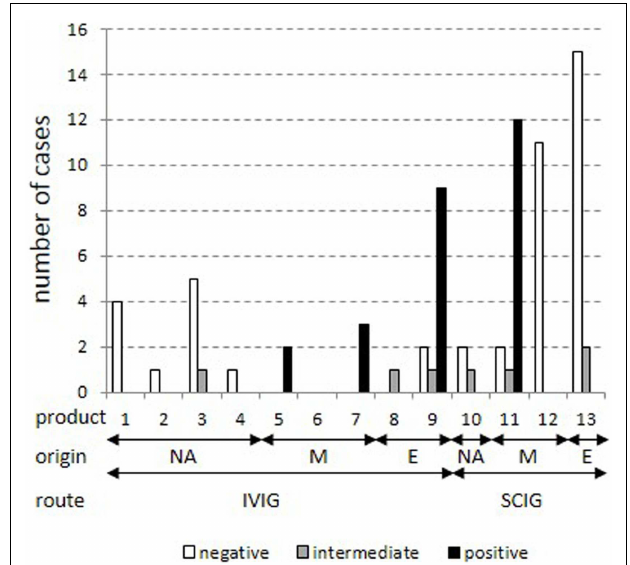
FIGURE 2 | Stratification of cases for each product in patients with IgG trough levels above 7g/l . All cases with total IgG trough levels above 7g/l were stratified into positive, intermediate, and negative results in the standard anti-TBE ELISA according to IgG products as coded in Table 2 . Plasma origin is indicated as North America (“NA”), mixture (“M”), and Europe